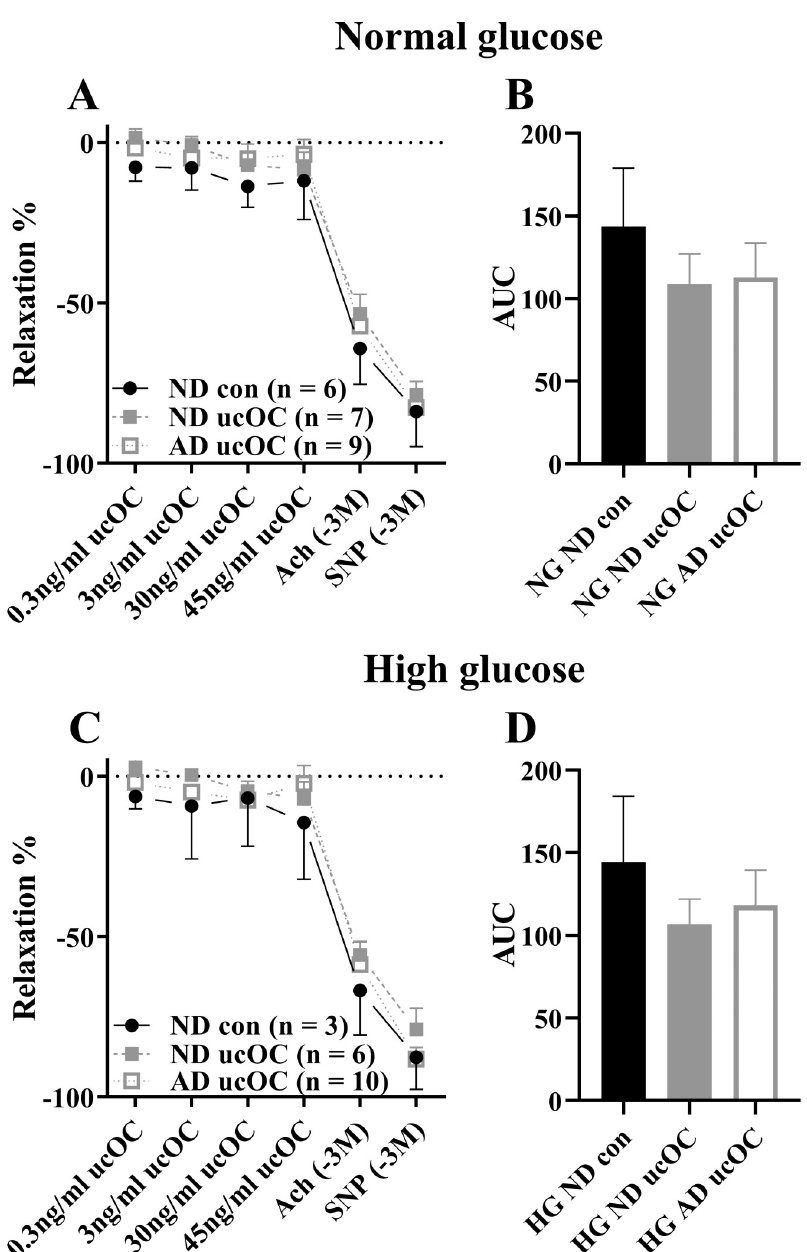
Fig 2. ucOC administration to carotid artery following 2-hour incubation in NG or HG solution. (A) ucOC dose response curve in carotid artery incubated in NG solution and (B) AUC of dose response curve. (C) ucOC dose response curve in carotid artery incubated in HG solution and (D) AUC of dose response curve. All data mean ± SEM. No significant differences were detected. Abbreviations : ucOC , undercarboxylated osteocalcin; NG , normal glucose media; HG , high glucose media; ND , normal diet; AD , atherogenic diet; Ach , acetylcholine; SNP , sodium nitroprusside .